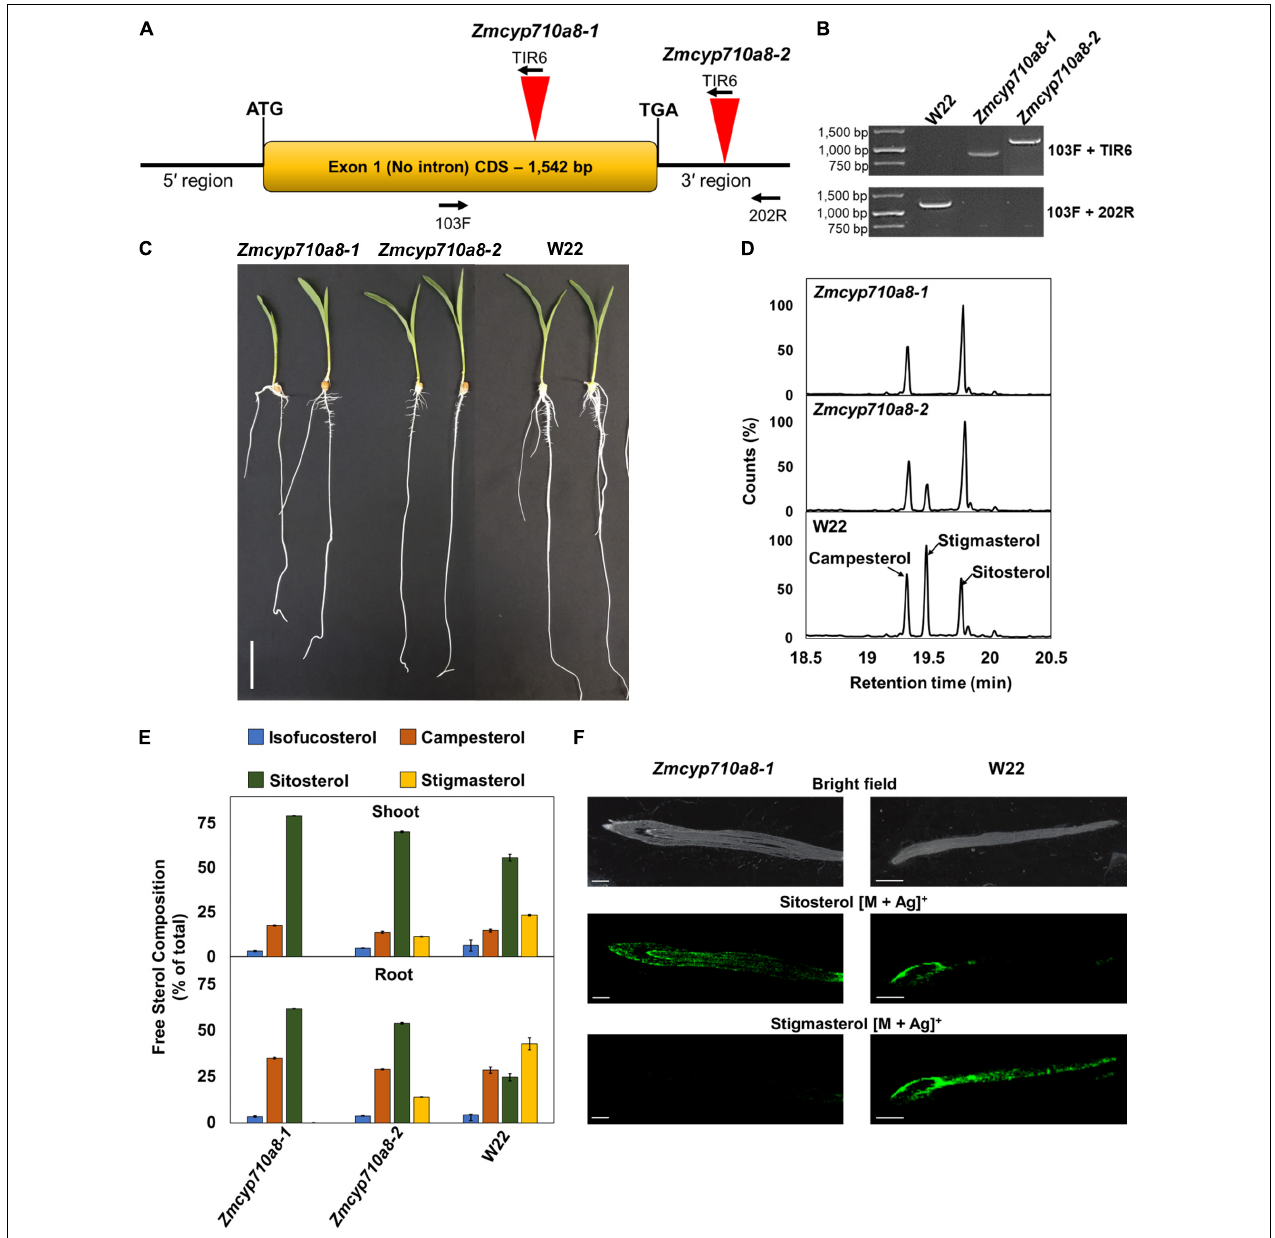
FIGURE 5 | ZmCYP710A8 is the sole maize C-22 sterol desaturase to synthesize stigmasterol. (A) Schematic of the ZmCYP710A8 gene structure with its 5 (cid:48) and 3 (cid:48) UTRs. The coding sequence is shown as a yellow box with the start (ATG) and stop (TGA) codons marked. Inverted red triangles show the site of transposable element insertions in Zmcyp710a8-1 and Zmcyp710a8-2 mutant alleles. The primer binding sites used for genotyping the mutations are indicated with 103F, 200R, and TIR6. (B) Identification of transposon insertion in the Zmcyp710a8 mutant alleles by PCR genotyping. The top panel shows PCR reactions amplified using one primer binding to the transposon and the other to the genome and the bottom panel shows amplicons from both primers binding to the genome. Transposon insertion would not lead to amplification of wild type band in mutants. Primer pairs are as shown in panel (A) . W22 is the wild type control. DNA ladder is also shown. (C) Representative images of 11-day old wild type and mutant maize seedlings grown by cigar roll method. Scale bar = 5 cm. (D) Representative GC-MS total ion chromatogram traces of root tissues from Zmcyp710a8-1 , Zmcyp710a8-2 mutant alleles and wild type (W22) are shown. The three major sterols are indicated. (E) The composition (% of total sterols) of free major sterols in shoot and root of the two mutant alleles and wild type are shown. Tissue samples were pooled from 3 individual seedlings in one experiment. Sterol extraction was performed for two independent experiments and measured in four technical replicates for each experiment and the data shown are means ± SD. Root is as shown in panel (C) and shoot is a pool of all the above ground tissue shown in panel (C) . (F) Mass spectrometry images of sterols in roots of 3-day-old maize seedlings. Root tip end is on the left side of images. The monoisotopic mass for each sterol were monitored with both major isotopes of silver ( 107 Ag and 109 Ag). The MS images are of sitosterol silver adducts ( m/z 523.2913 and 521.2913) and stigmasterol silver adducts ( m/z 519.2856 and 517.2865). Respective bright field images are included as the special reference for the MSI data. MSI images were captured using a 50 µ m raster size. The images are representative of two experiments. Scale bar = 1